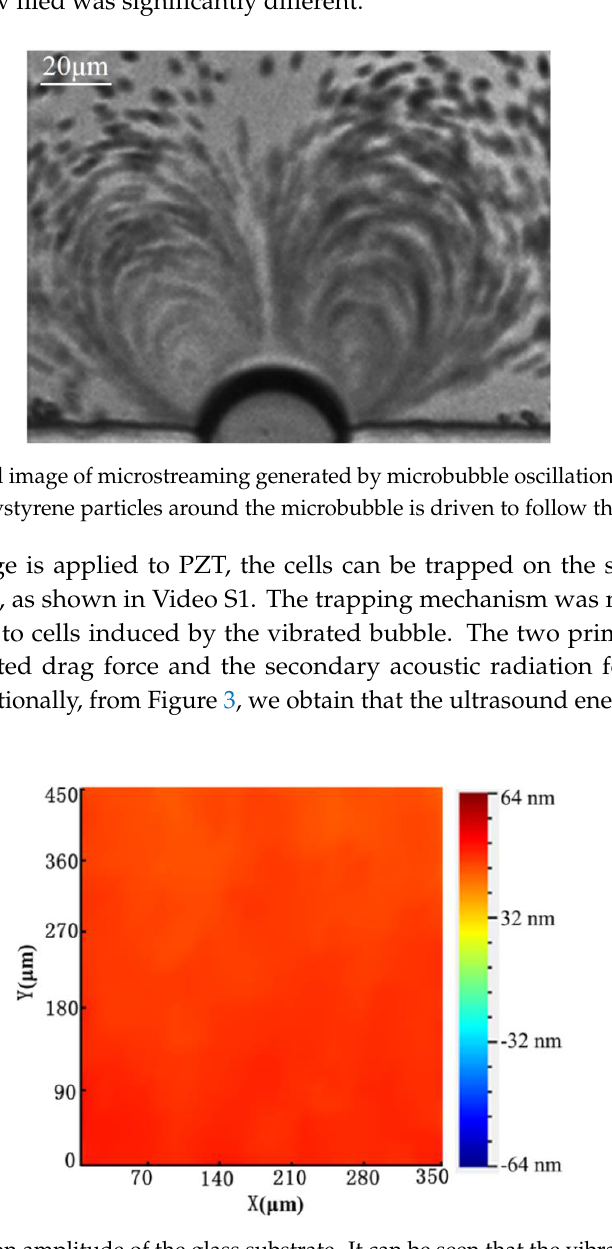
Figure 3. The vibration amplitude of the glass substrate. It can be seen that the vibration amplitude of the position, where the PDMS channel is located, is relatively uniform.